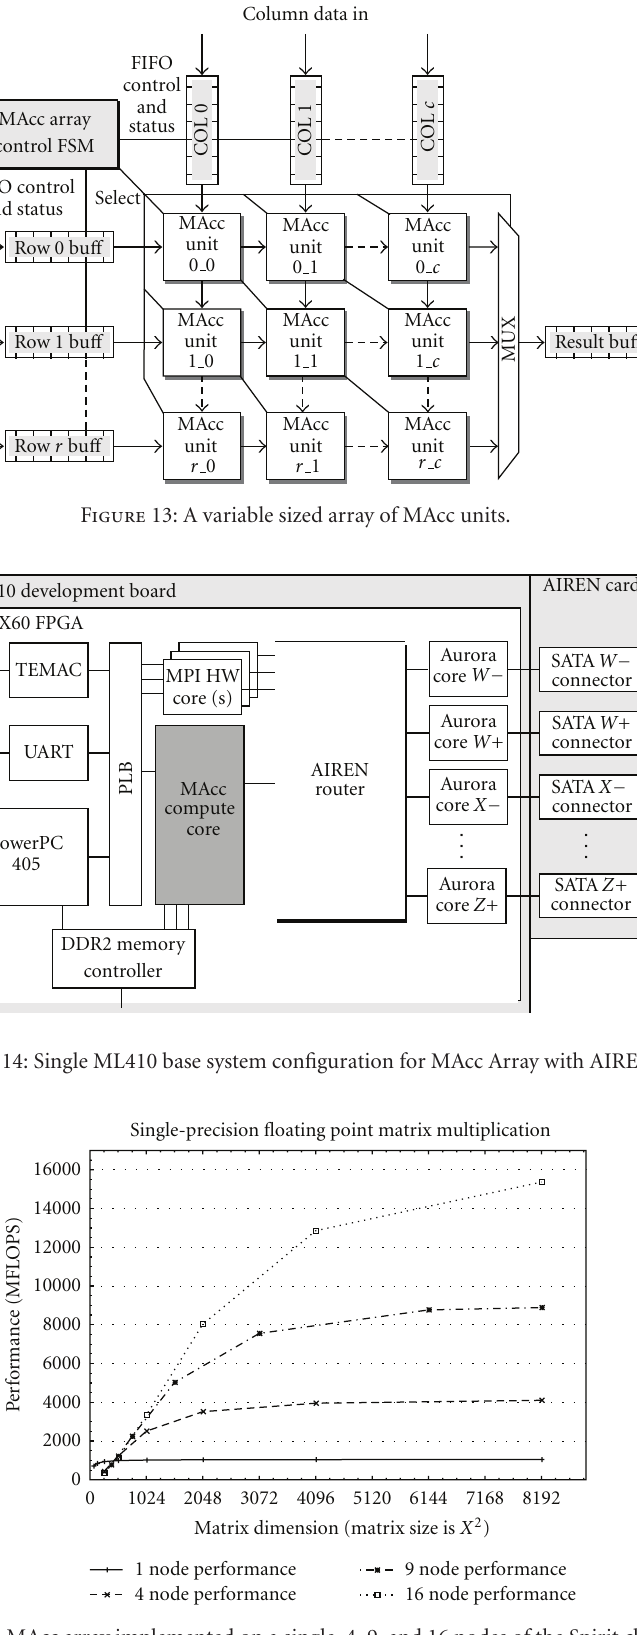
Figure 15: Performance of the 8 × 2 MAcc array implemented on a single, 4, 9, and 16 nodes of the Spirit cluster with the AIREN